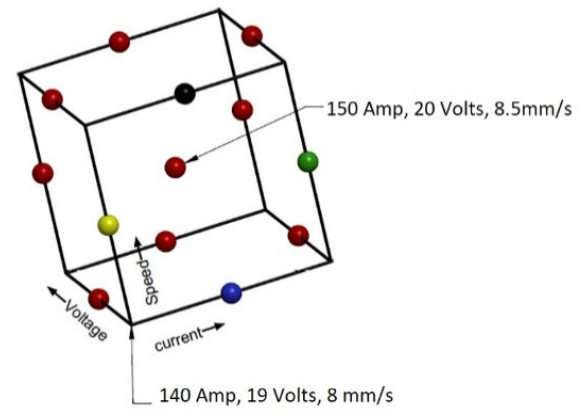
Figure 6. Weld parameters in Box–Behnken design. The yellow dot on the front face of the cube represents the first experimental run, with welding current 140 A, voltage 19 V, and a welding speed of 8.5 mm/s. The blue dot represents the ninth experimental run in Table 1. The green dot represents the third experimental run, and the black dot represents the tenth experimental run. On the front face of the cube, welding voltage is constant during all four experiments, while welding speed and voltage vary from mid-point to the maximum level. The weld process simulation of each experiment is performed by finite element analysis. The distortion produced during welding is observed and analyzed with the help of regression